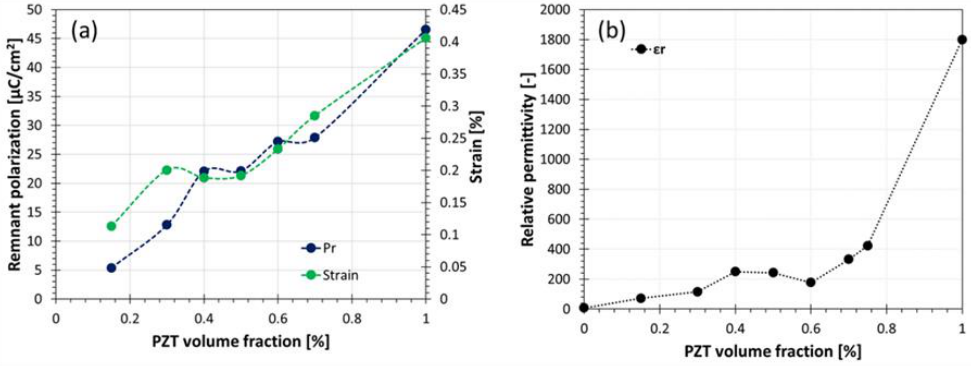
Figure 8. Electromechanical properties ( a ) remnant polarization and maximal strain elongation ( b ) relative permittivity for